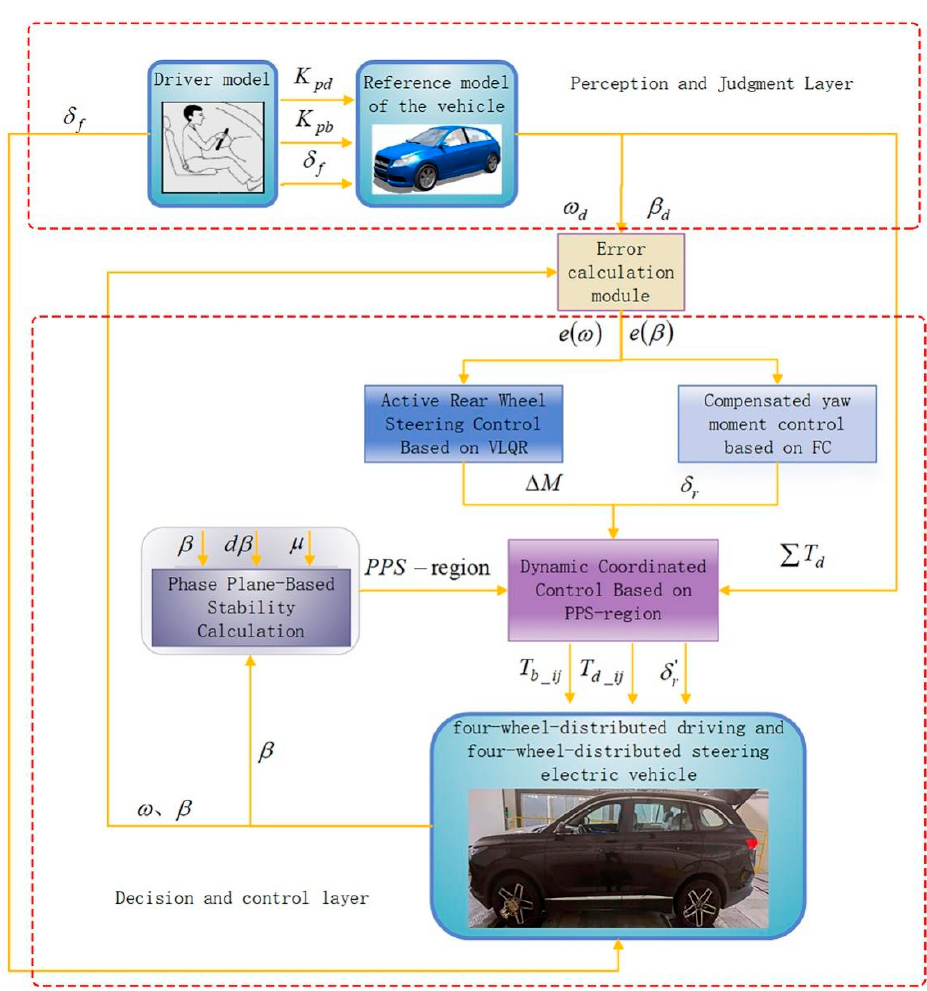
Figure 4. Structure block diagram of dynamics coordinated control system.